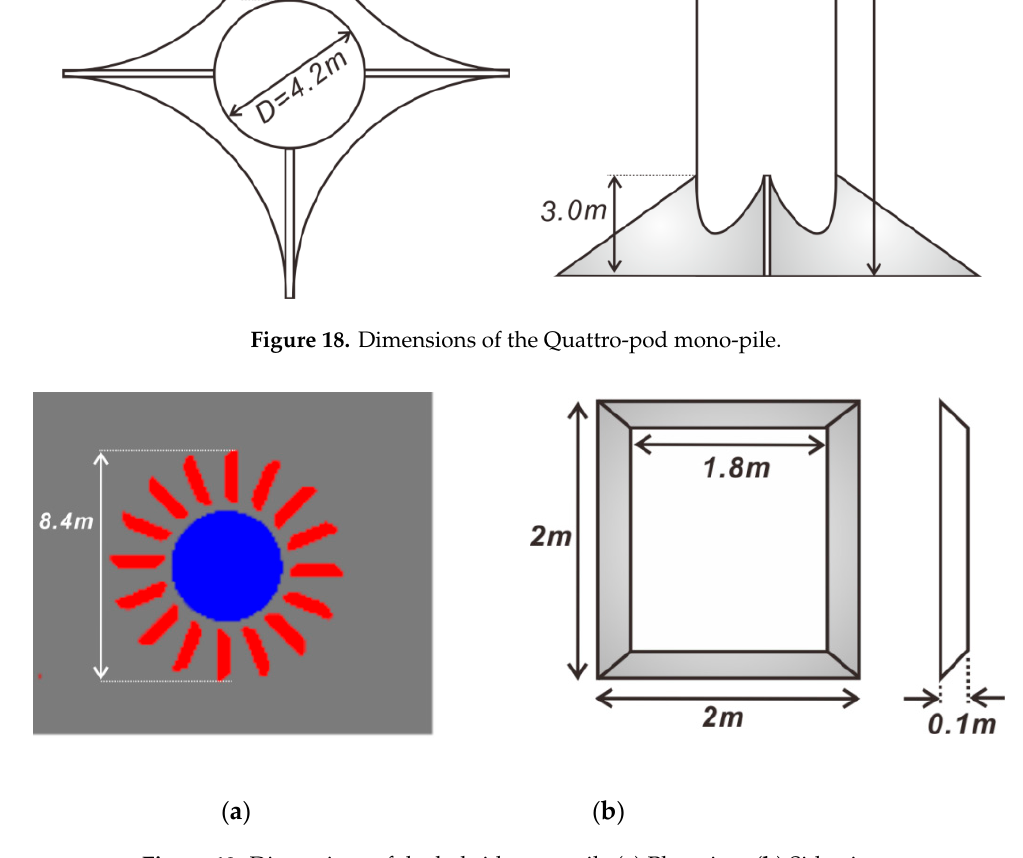
Figure 20. Initial morphology in the case of a simple monopile ( a ) Plan view, ( b ) Side view.